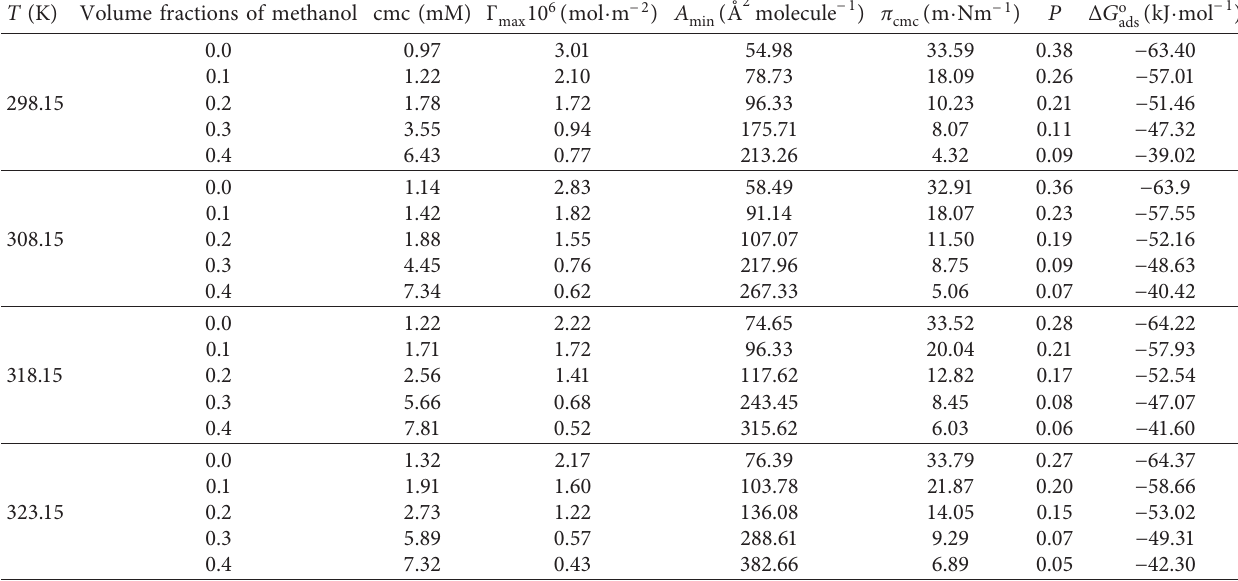
), packing parameters ( P ), and free energy of adsorption ( Δ G o cmc